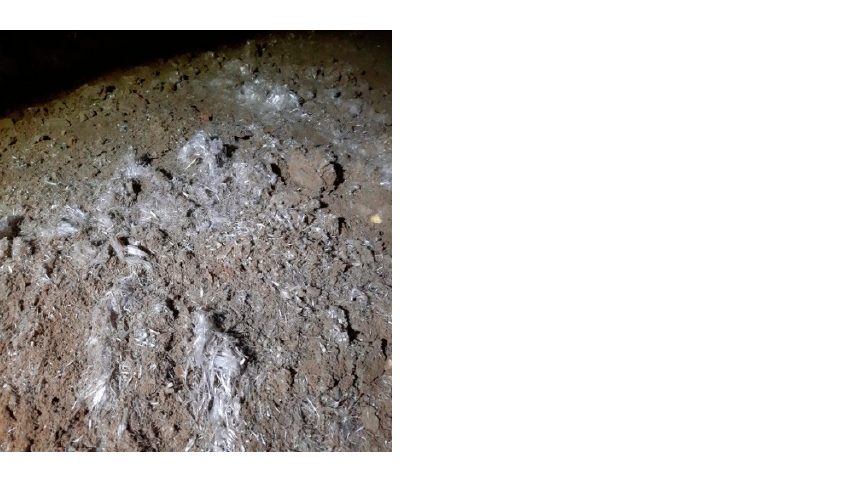
Figure 1. Photograph of salt destruction on consolidated soil surface at the Kuahuqiao Museum.